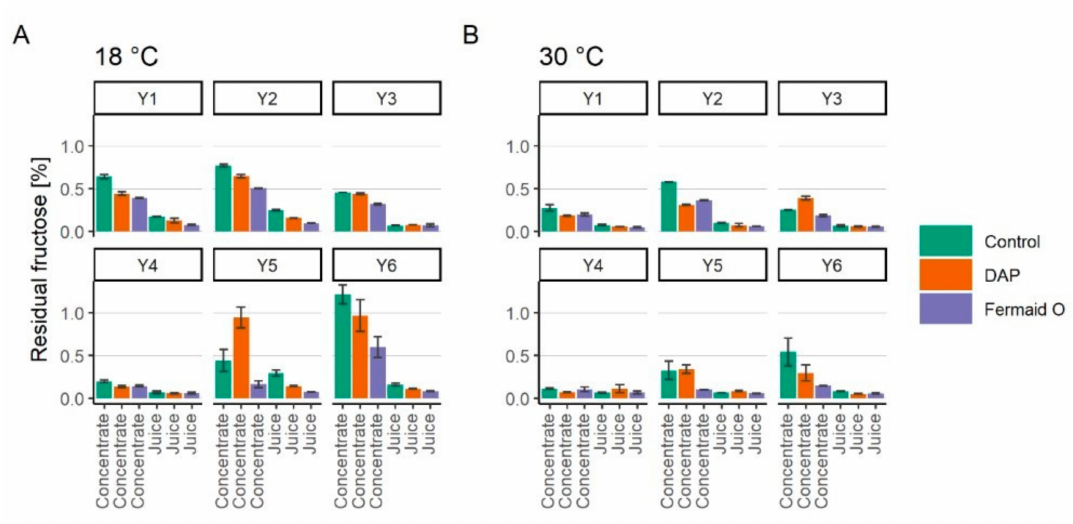
Figure 2. Residual fructose concentration at the end of fermentations prepared from fresh juice or juice concentrate with di ff erent yeasts (Y1-Y6) at 18 or 30 ◦ C ( p < 0.05). The color green represents control samples, orange—supplemented with DAP (diammonium phosphate), purple—supplemented with Fermaid O. ( A ) represents the samples fermented at 18 ◦ C; ( B )—at 30 ◦ C. Red lines represent initial malic acid content either in juice or reconstituted